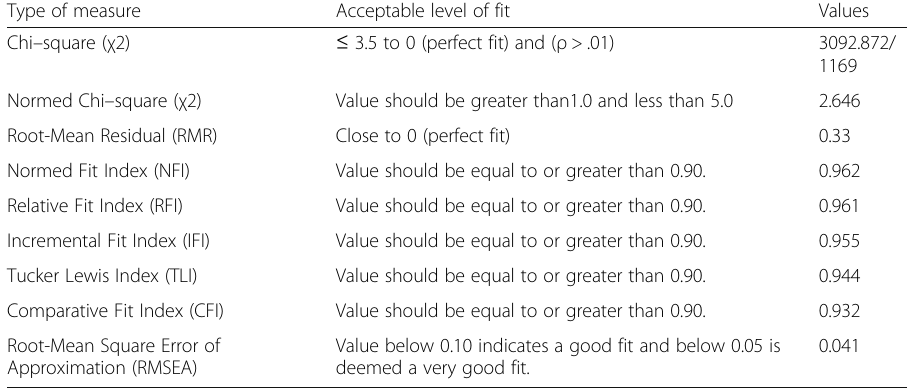
Table 1 Summary of Goodness Fit Indices for the Measurement Model (IDT and